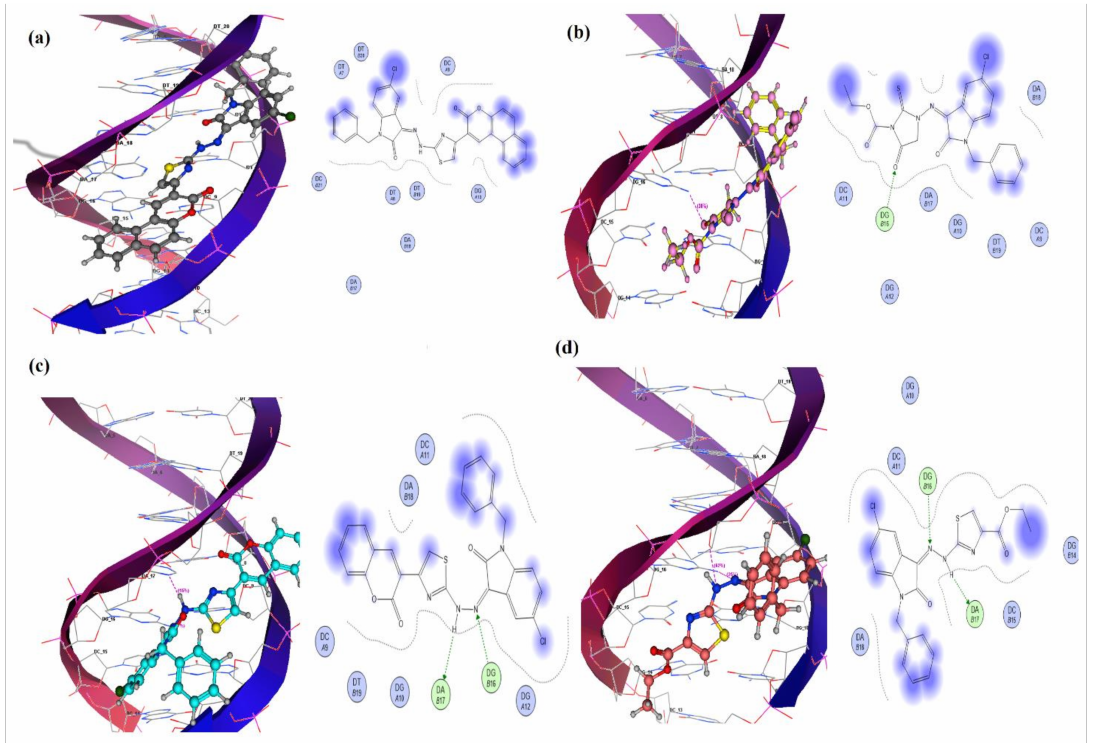
Figure 5. Docked complexes with DNA base pairs PDB (ID: 2DBE) along with 2D lig plots. ( a – d ): IST-01, IST-02, IST-03, and IST-04.